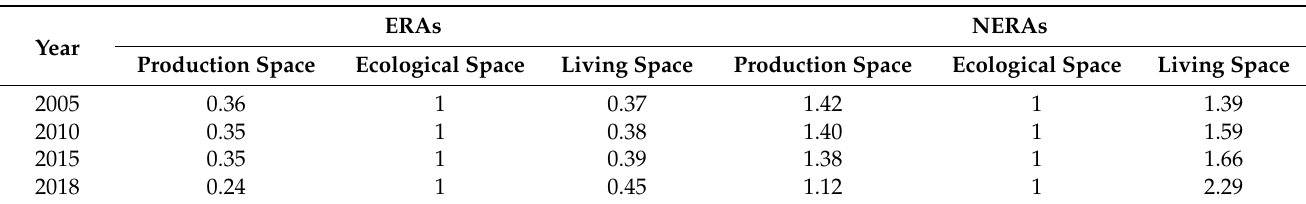
Table 4. The proportion of production, ecological, and living spaces in the ERAs and NERAs between 2005 and 2018. ERAs NERAs Year Production Space Ecological Space Living Space Production Space Ecological Space Living Space 2005